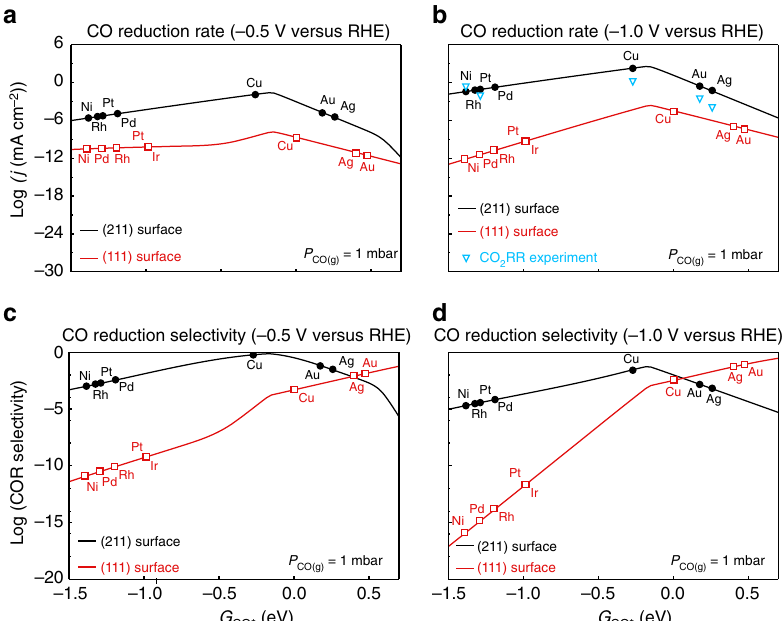
Figure 4 | Activity volcanoes for flat (111) and stepped (211) transition metal surfaces as a function of CO binding energy. At ( a ) (cid:2) 0.5V versus RHE, ( b ) (cid:2) 1.0V versus RHE, as determined through microkinetic modelling. CO 2 reduction experimental data from refs 2,41,43; CO pressure estimated 66 to be 1mbar under CO 2 reduction conditions, pH ¼ 7. Selectivity towards CO reduction at ( c ) (cid:2) 0.5V versus RHE, ( d ) (cid:2) 1.0V versus RHE, defined as the rate of CO reduction relative to the sum of the rate of CO reduction and hydrogen evolution. CO 2 RR, carbon dioxide reduction